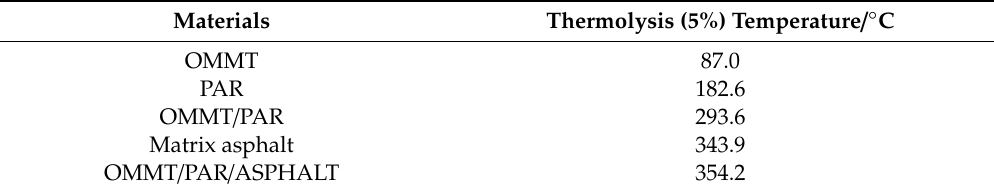
Figure 4. TG curves of OMMT, PAR and their composites. Table 7. Thermolysis temperature of OMMT, PAR and their composites.